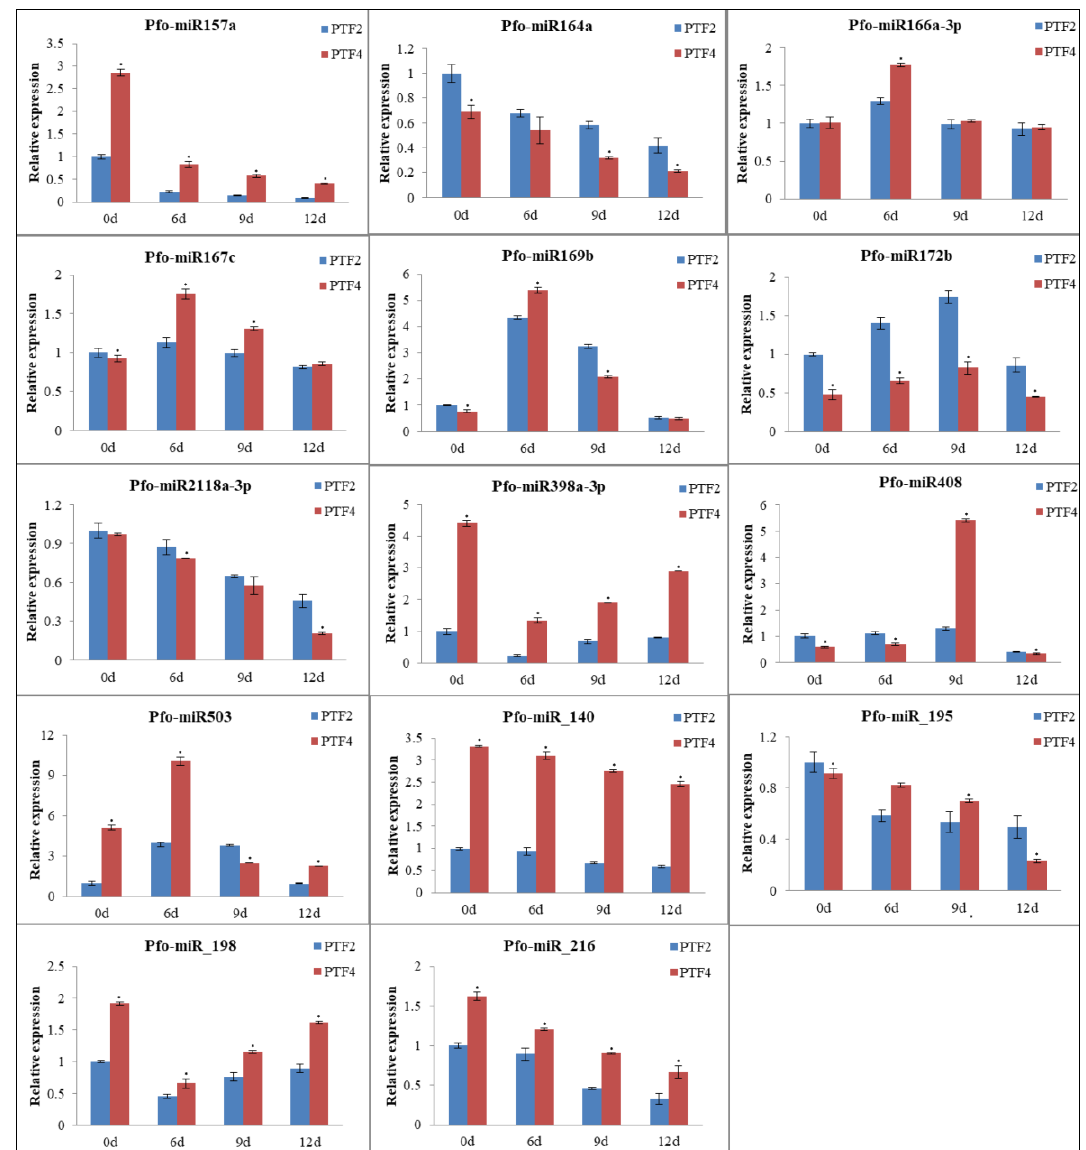
Figure 7. Relative expression levels of drought response miRNAs in two P. fortunei genotypes. U6 snRNA was used as the endogenous reference gene. Bar = Standard deviation. The difference between the diploid and autotetraploid P. fortunei within each drought treatment time point was significant (*, p < 0.05) according to the t -test. 0d, well-watered diploid and autotetraploid plants; 6d, 6 days drought-treated diploid and autotetraploid plants; 9d, 9 days drought-treated diploid and autotetraploid plants; 12d, 12 days drought-treated diploid and autotetraploid plants.